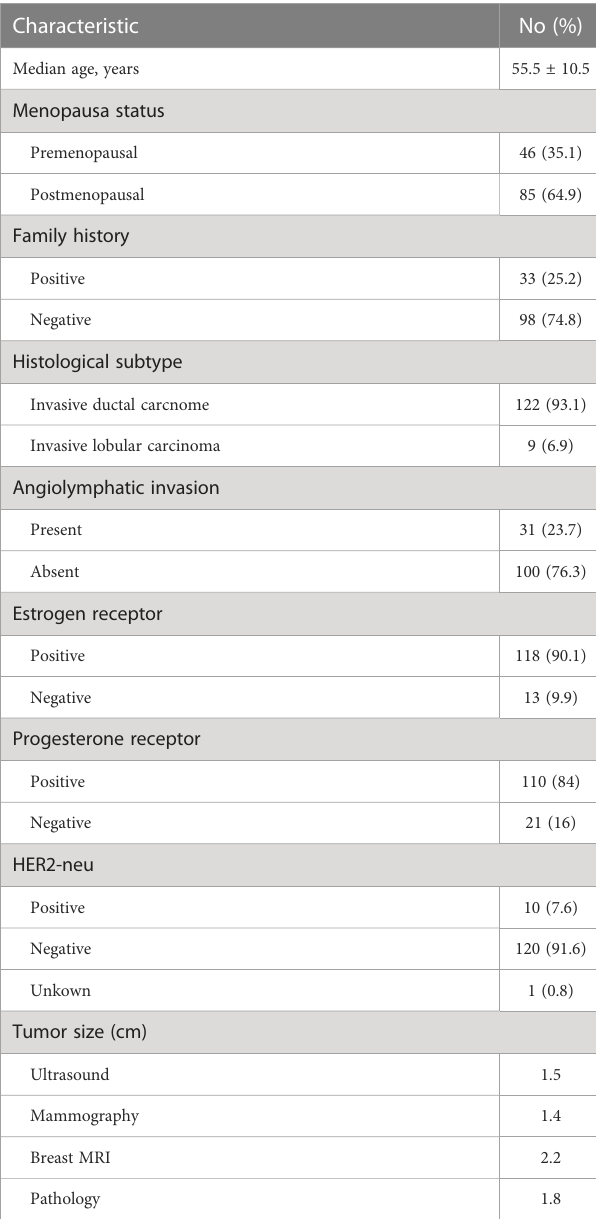
multifocal lesions on breast MRI and pathological tumor size TABLE 1 Clinical and pathological features of study cohort.